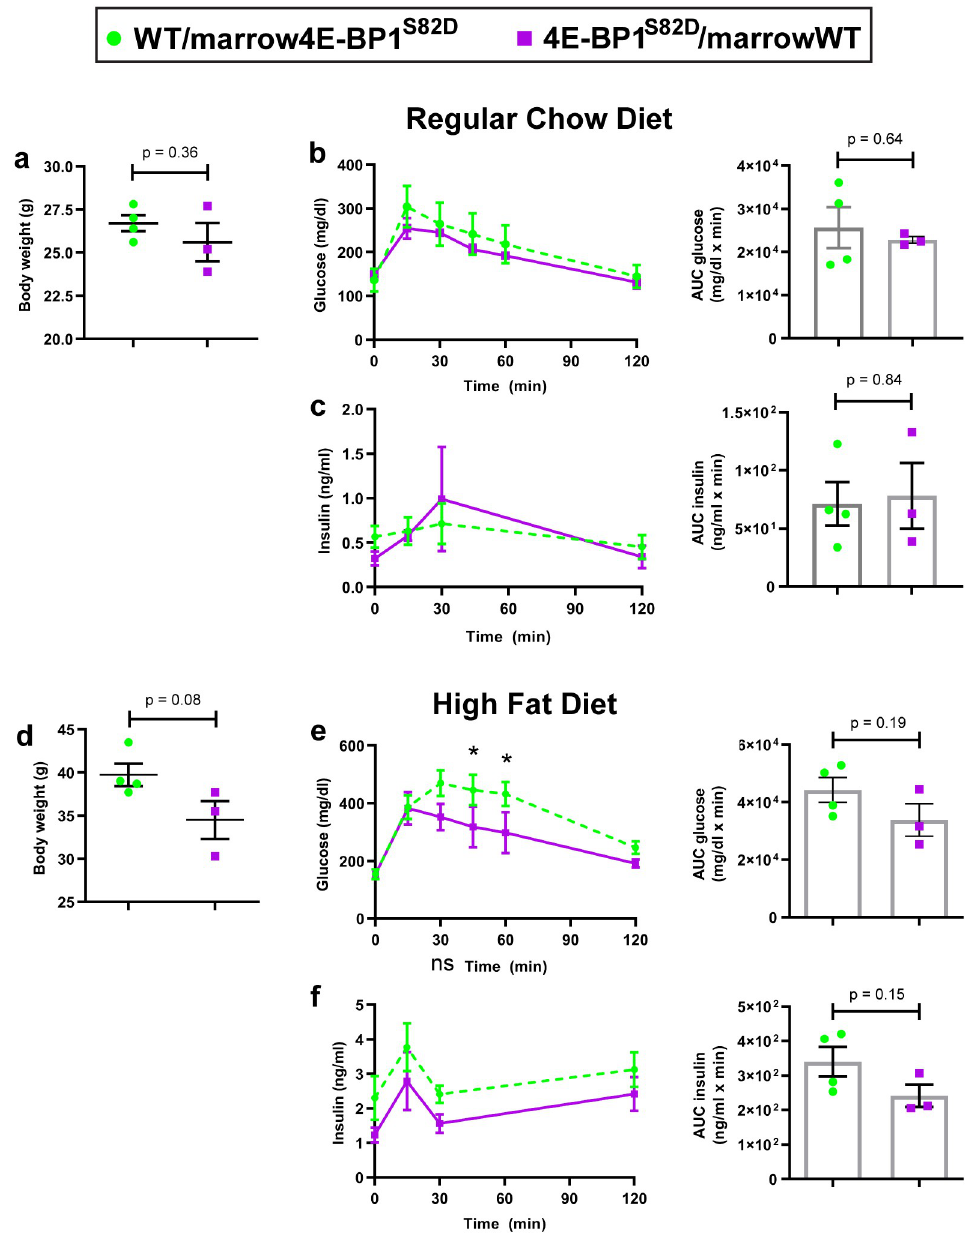
Fig 2. WT mice transplanted 4E-BP1 S82D bone marrow (WT/marrow4E-BP1 S82D , n = 4) trend towards reduced glucose tolerance compared to 4E-BP1 S82D mice transplanted WT bone marrow (4E-BP1 S82D /marrowWT, n = 3) after HFD challenge. After confirmation of successful reciprocal bone marrow transplantation, mice were preconditioned on RCD and measured for body weight prior to glucose tolerance test (GTT) (a) , serum glucose levels during GTT (b) , and serum insulin levels during GTT (c) . After switching from RCD to HFD, the mice were preconditioned on HFD and measured for body weight prior to glucose tolerance test (GTT) (d) , serum glucose levels during GTT (e) , and serum insulin levels during GTT (f) . Mean and SEM are shown, and each plotted point represents one mouse. GTT results shown as time course and area under the curve graphs. Two-tailed t-tests were used to compare groups. Comparisons at each data point were not significant (p � 0.05) unless noted with an asterisk. � p < 0.05.